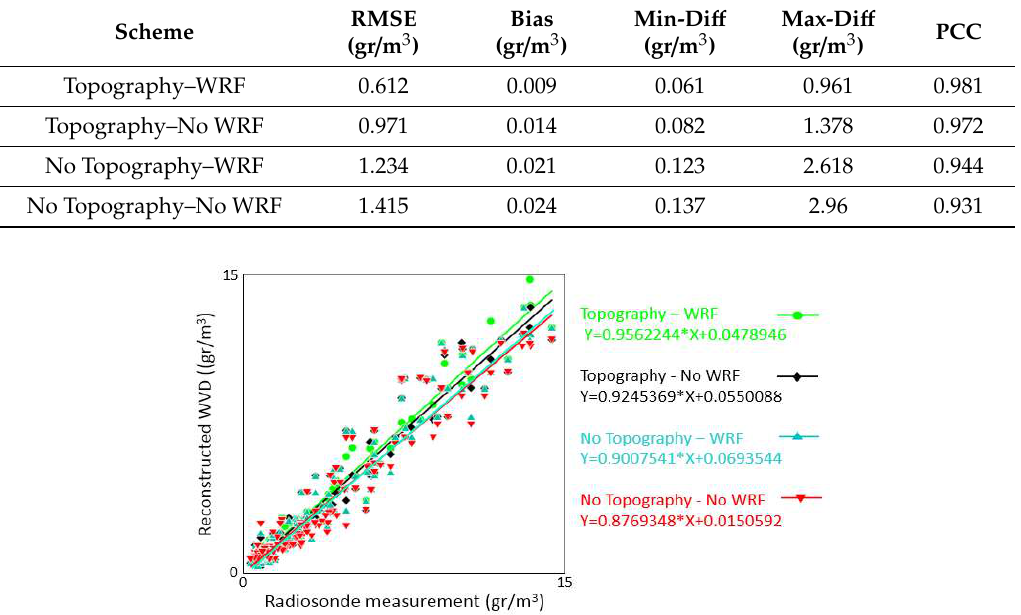
Figure 13. Scatter plot between the reconstructed WVD and radiosonde measurements.